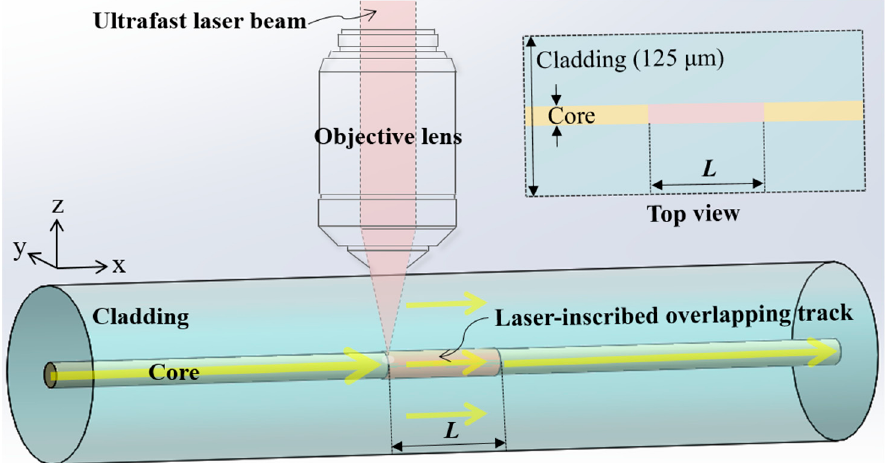
Figure 1. Schematic of the proposed fiber-optic RI sensor, with a section of the SMF core completely reshaped. Inset (top-right corner): top view observed in the x - y plane of the core including the reshaped section of length L in pink.